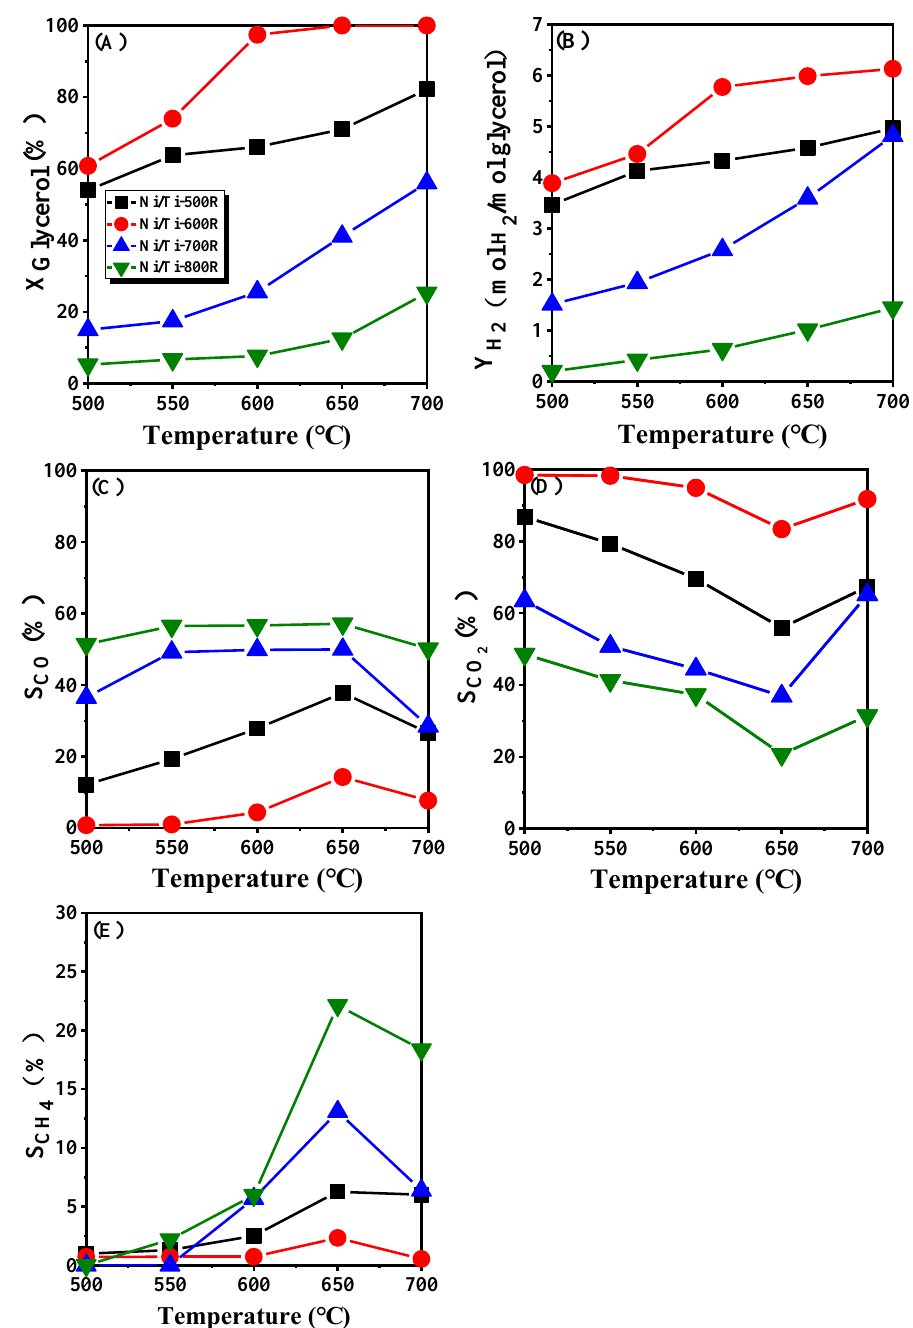
Figure 6. GSR activity of the catalysts ( A ) glycerol conversion, ( B ) H 2 yield, ( C ) CO selectivity, ( D ) CO 2 selectivity, ( E ) CH 4 selectivity. Reaction conditions: 30 wt.% glycerol/water solution, WHSV = 9 h − 1 , 1